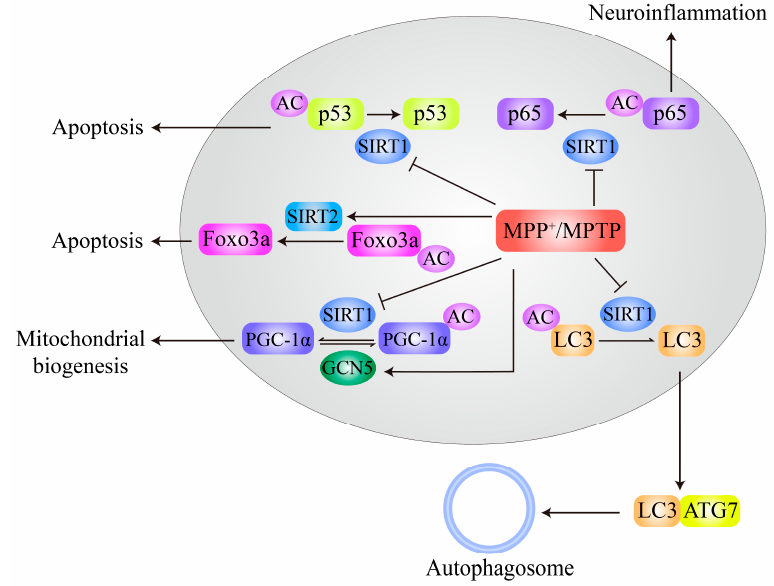
/ MPP + on acetylation of nonhistone proteins. MPTP / MPP + inhibits Figure 4. Effects of MPTP/MPP + on acetylation of nonhistone proteins. MPTP/MPP+ inhibits SIRT1 Figure 4. Effects of MPTP